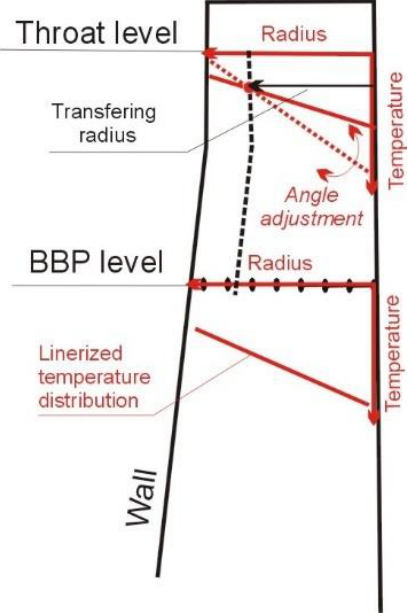
Figure 3. Calculation scheme of gas distribution at the throat